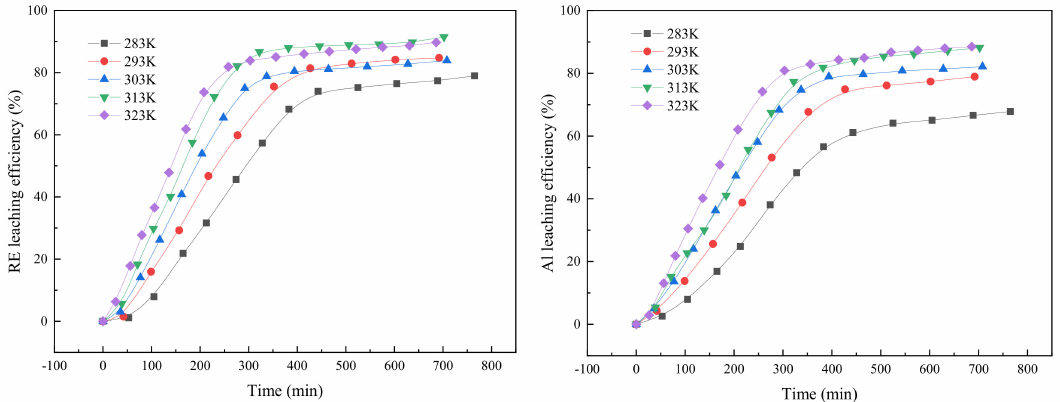
Figure 10. E ff ects of experimental temperatures on the leaching rate of RE and